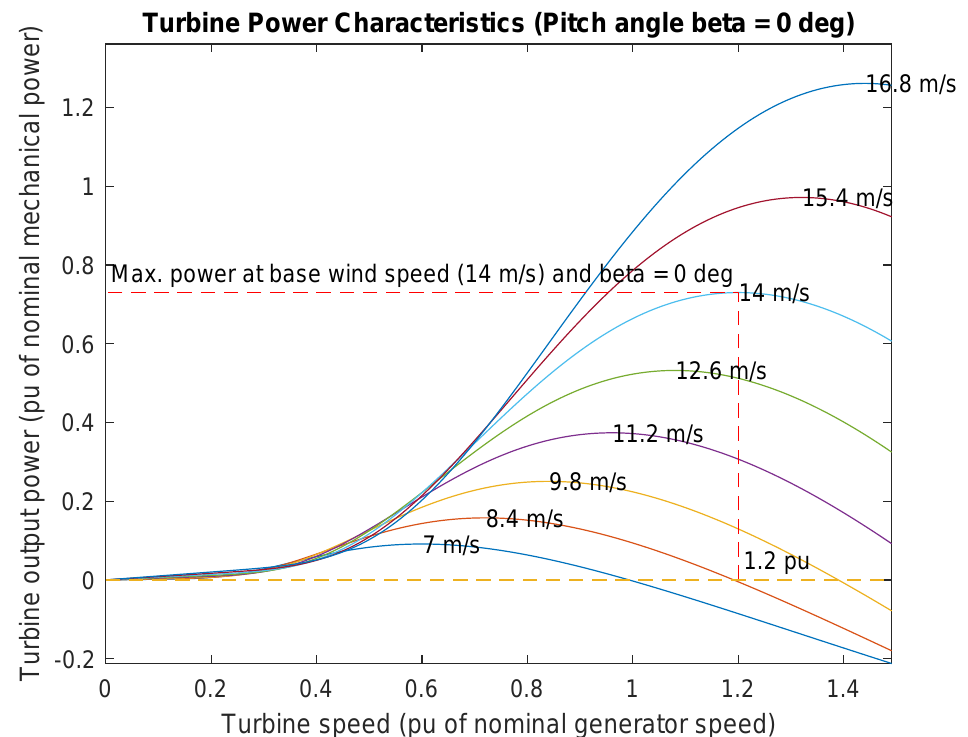
Figure 5. Wind Turbine Model Power Characteristic Curve.